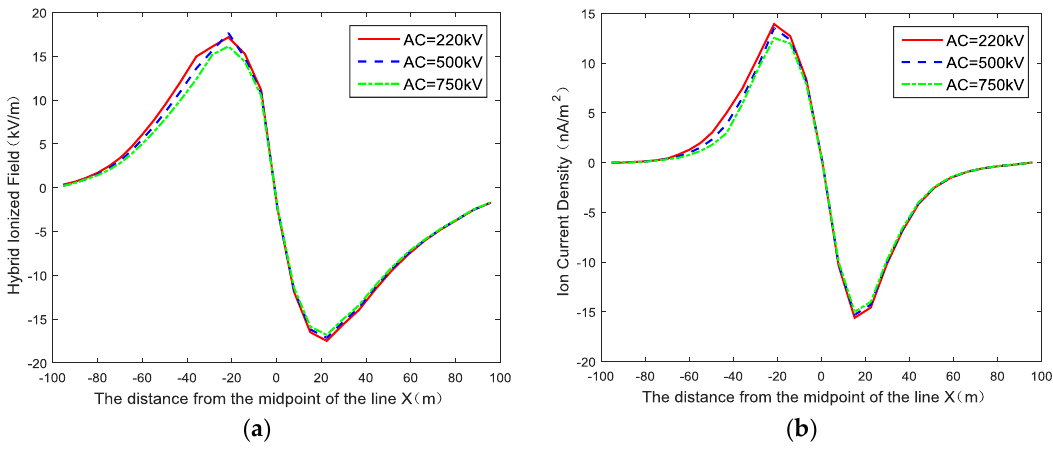
Table 2. The value and growth rate of calculation results when the AC voltage is changed.